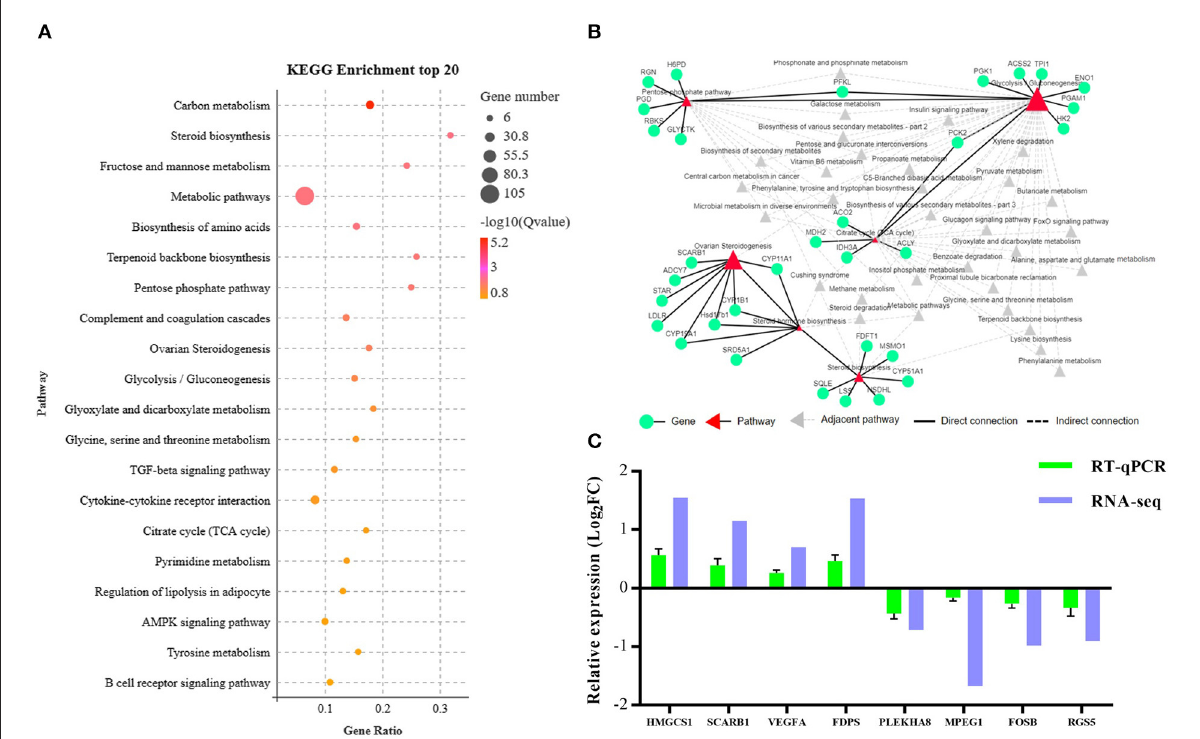
FIGURE4 Bioinformatics analysis and validation of DEGs between the NCG and Control groups based on the data presented in the Kyoto Encyclopedia of Genes and Genomes (KEGG) pathway analysis. (A) Top 20 terms (Control vs. NCG) for KEGG enrichment; (B) Correlation network corresponding to the DEG enriched pathways associated with steroid biosynthesis, pentose phosphate pathway, ovarian steroidogenesis, glycolysis/gluconeogenesis, and citrate cycle (TCA); (C) Expression levels of the eight functional DEGs as determined by RNA-seq using RT-PCR, n =